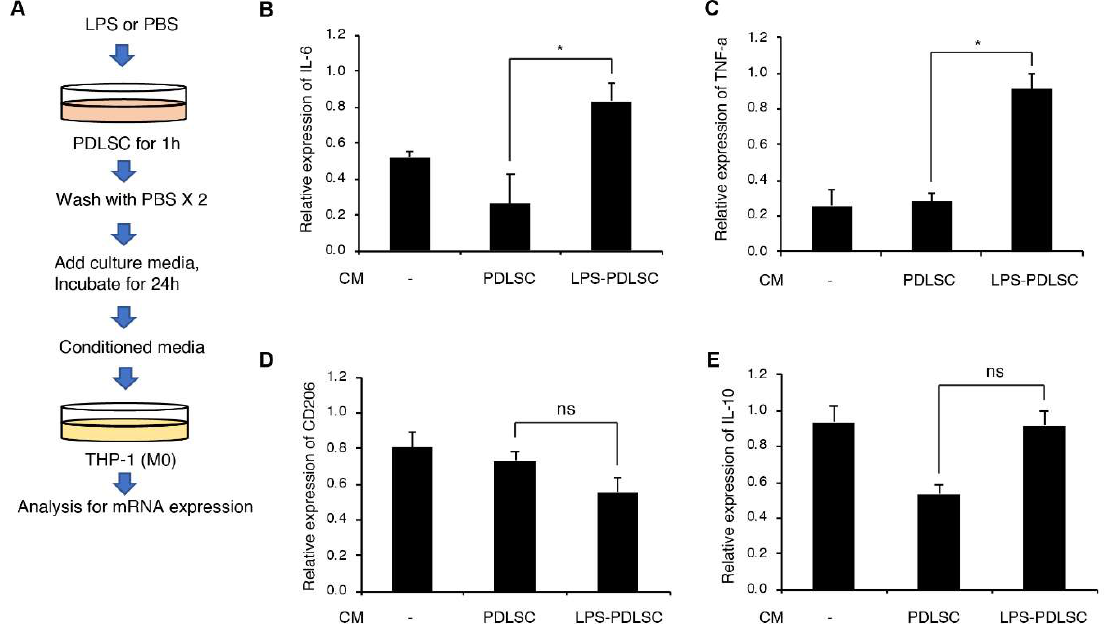
Figure 2. Effect of PDLSCs or LPS-preconditioned PDLSCs on the polarization of the macrophage cell line, THP-1. ( A ) Schematic diagram for the experimental process. M1 or M2 polarization of THP-1 cells by the conditioned media from PDLSCs or Lipopolysaccharide (LPS)-preconditioned PDLSCs. Relative mRNA expression of interleukin (IL)-6 ( B ), Tumor necrosis factor (TNF)- α ( C ), CD206 ( D ), and IL-10 ( E ) were analyzed by RT-qPCR. CM: the conditioned medium from PDLSC and LPS-PDLSC. Data are shown as the mean ± SD, n = 3, ns: not significant, * p < 0.05.